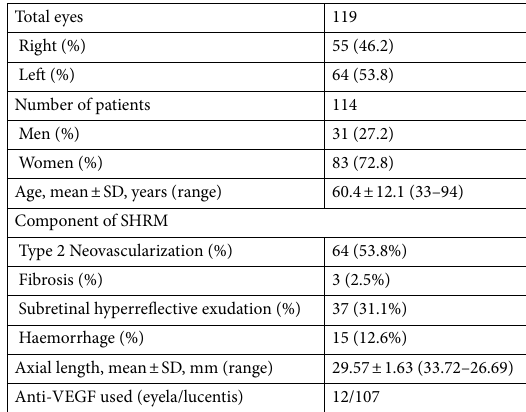
Table 1. Baseline characteristics of all study eyes. SD standard deviation, SHRM subretinal hyperreflective material, VEGF vascular endothelial growth